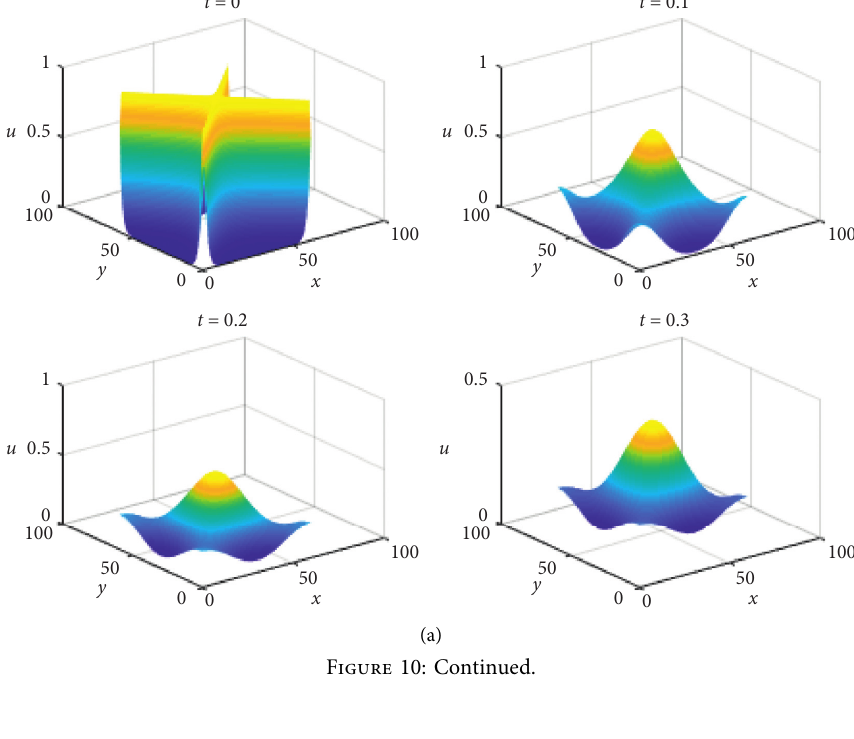
− b space of Experiment 2 with c � 0 . 83 , a � 0 . 69 , d 21